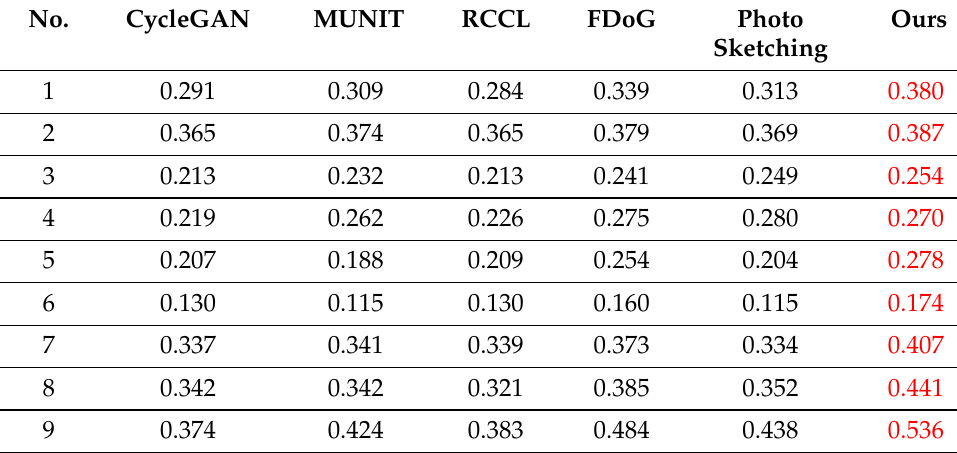
Table 3. The F1 scores estimated on the sketches in Figure 7. The red figures denote maximum F1 score in each